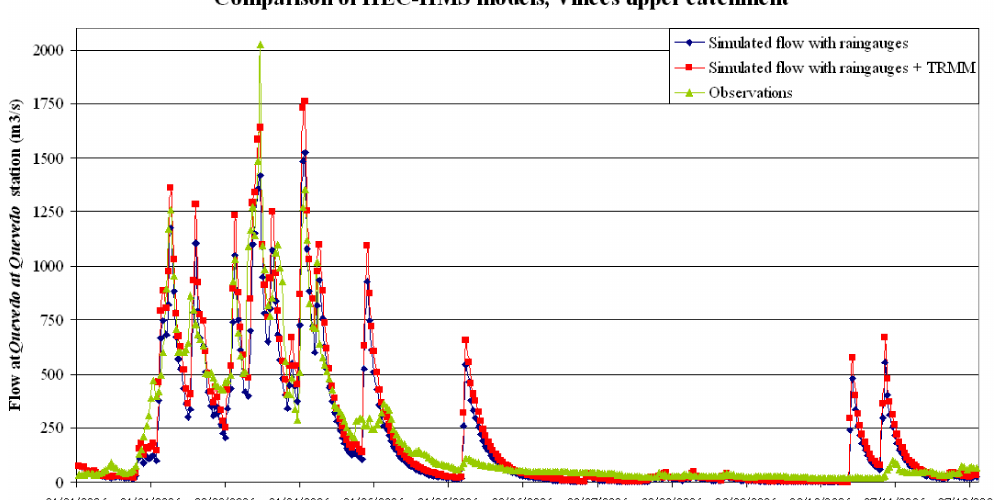
Fig. 7. Rainfall-runoff simulations with different types of precipitation data, Vinces River upper